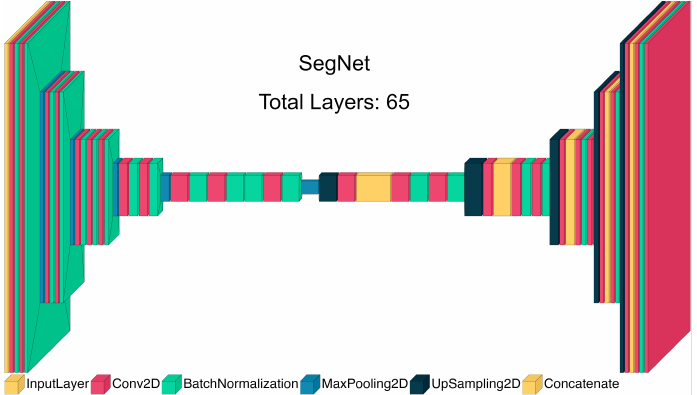
Figure 5. SegNet architecture for semantic segmentation.